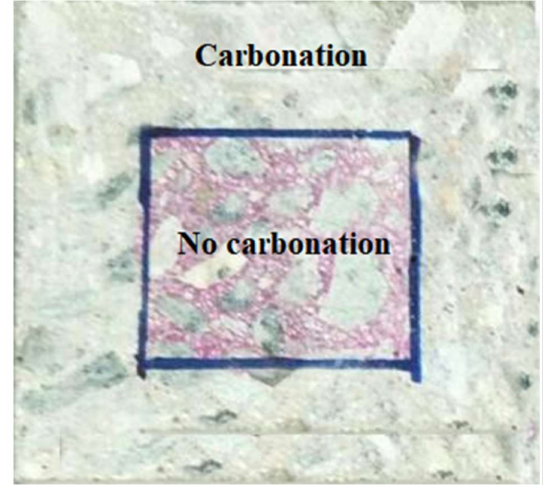
Figure 1. Carbonated concrete